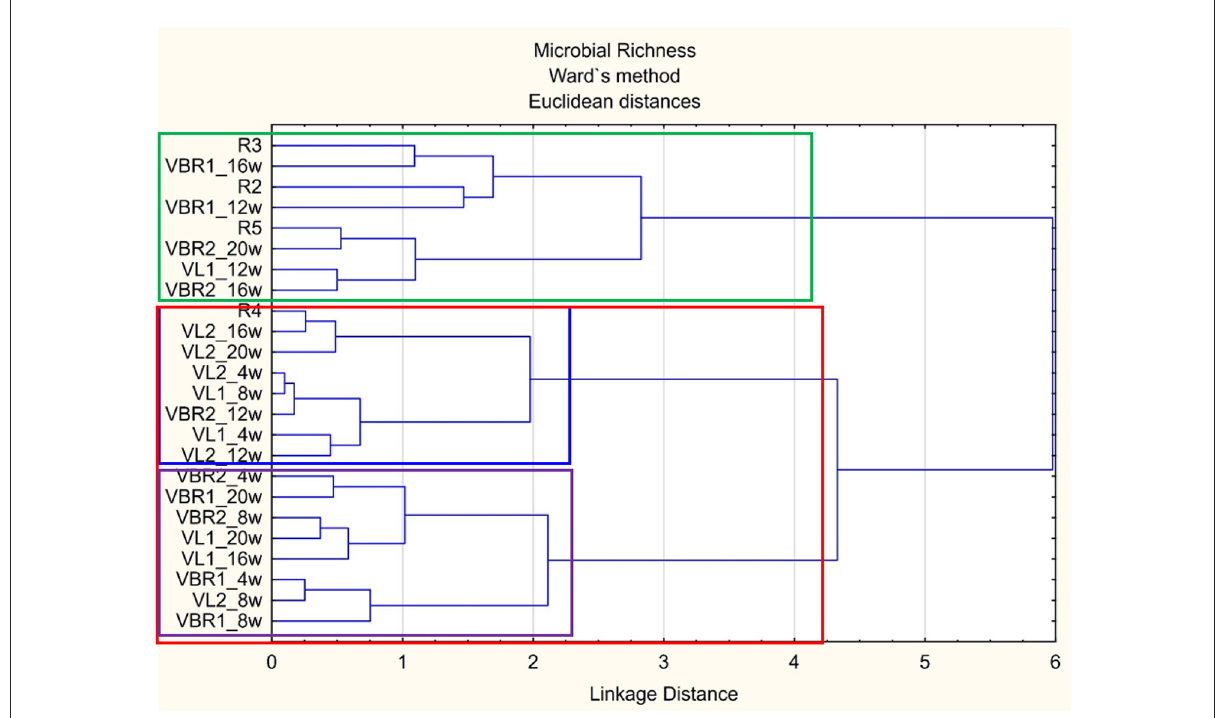
FIGURE1 Dendrogram illustrating the differences in microbial richness between landraces and growth stages soil samples over